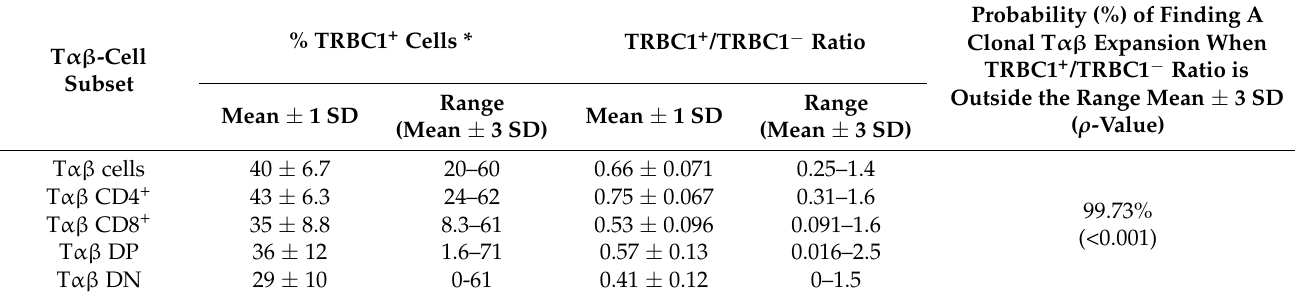
Table 3. Ranges for polyclonal (normal and reactive) total T αβ -cells and their major T αβ -cell populations in PB ( n = 83) as defined by the mean percentage of TRBC1 + cells and the mean TRBC1 + /TRBC1 − ratio ± 3 standard deviations (3 SD).